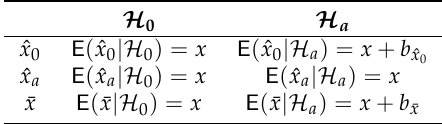
Table 1. The mean of the random parameters vectors ˆ x 0 , ˆ x a and ¯ x under H 0 and H a ,